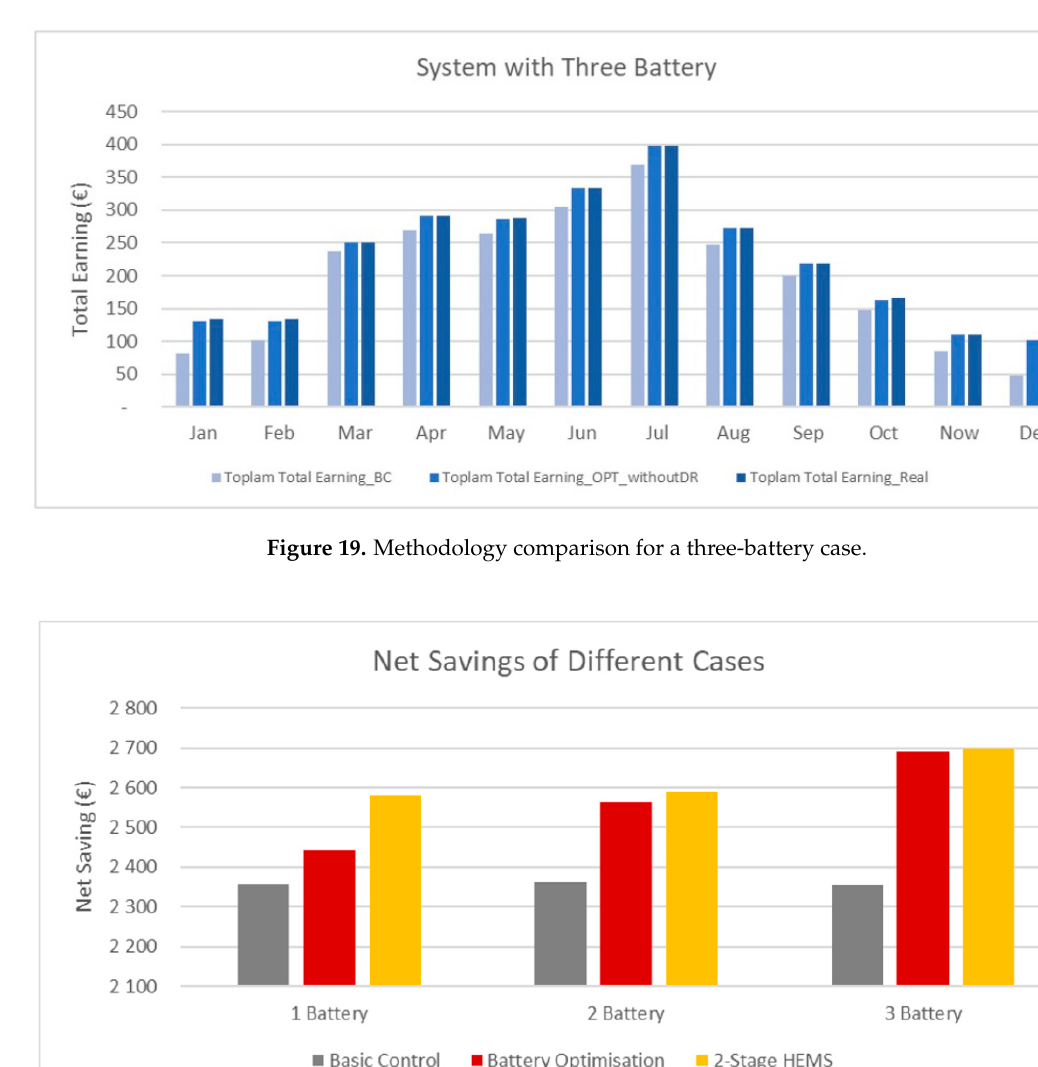
Figure 18. Methodology comparison for a two-battery case.